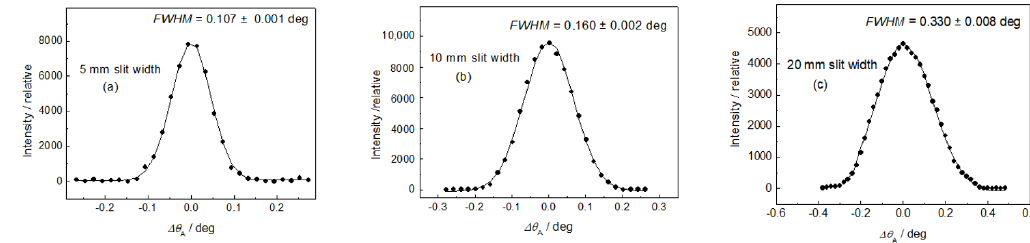
Figure 5. Rocking curves for the annealed α -Fe(110) low-carbon steel rods of ϕ = 4.9 mm in horizontal position: ( a ) 5, ( b ) 10, and ( c ) 20 mm Cd slits.